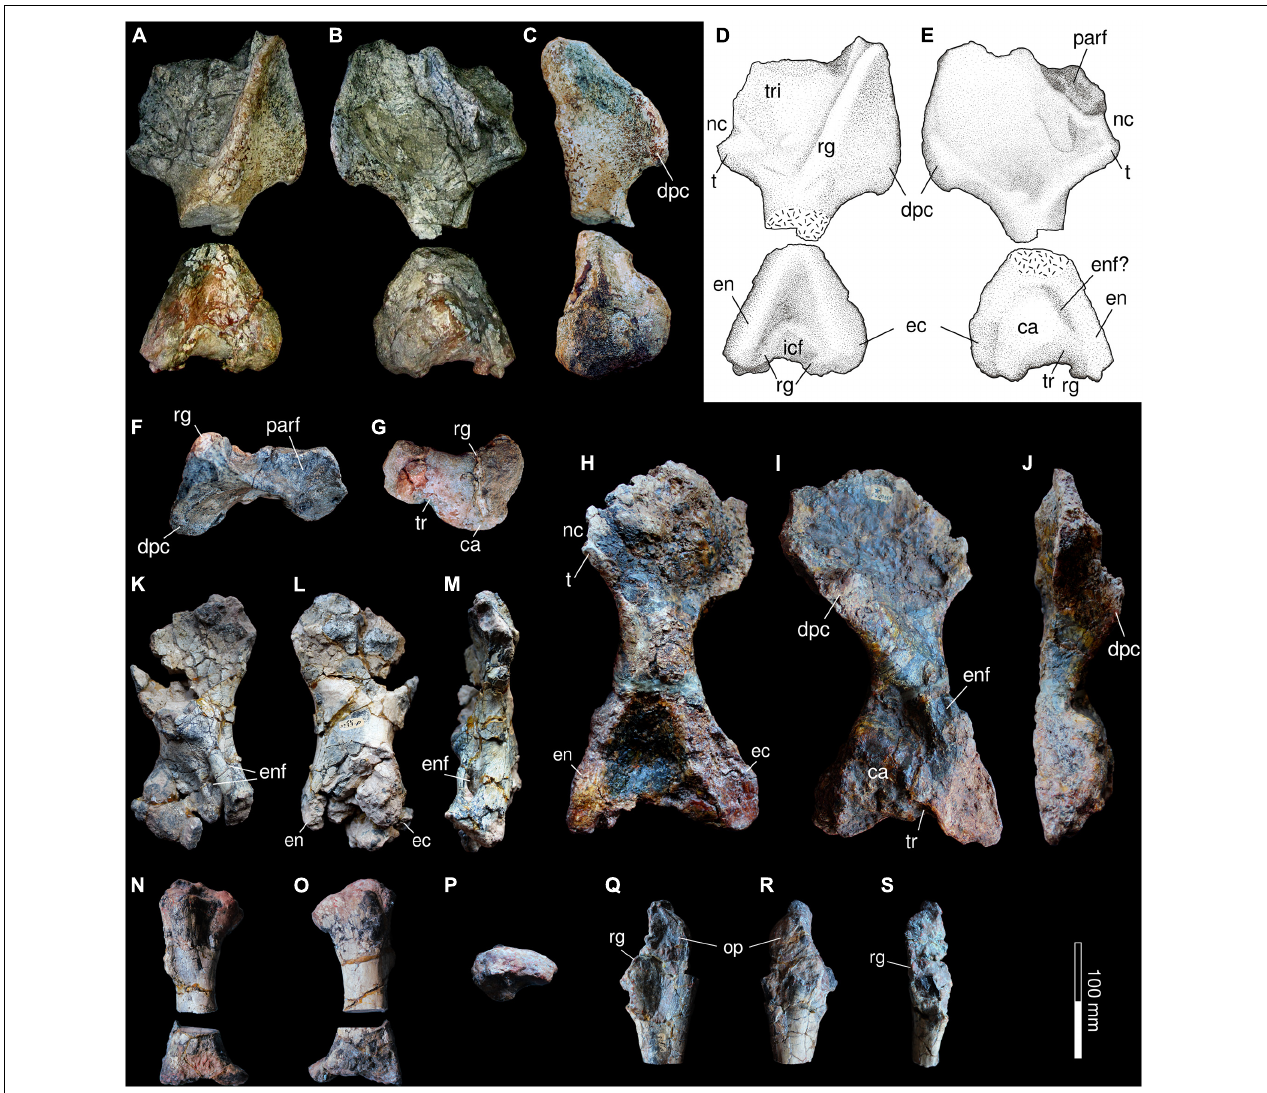
FIGURE 10 | Forelimb of Provelosaurus americanus . (A–G) UFRGS-PV-0359-P, right humerus in (A,D) dorsal (extensor), (B,E) ventral (flexor), (C) anterior, (F) proximal (dorsal to the top) and (G) distal (dorsal to the top) views. (H–J) UFRGS-PV-0231-P (holotype), right humerus in (H) dorsal (extensor), (I) ventral (flexor) and (J) anterior views. (K–M) UFRGS-PV-0233-P, right humerus in (K) dorsal (extensor), (L) flexor (flexor), and (M) anterior views. (N–P) UFRGS-PV-0233-P, right radius in (N) medial, (O) lateral, and (P) proximal views. (Q–S) UFRGS-PV-0233-P, right partial ulna in (Q) medial, (R) lateral, and (S) adductor view. ca, capitulum; dpc, deltopectoral crest; ec, ectepicondyle; en, entepicondyle; enf, entepicondylar foramen; icf, intercondylar facet; op, olecranon process; parf, proximal articular surface; nc, notch; rg, ridge; t, tubercle; tr, trochlea; tri, facet for attachment of